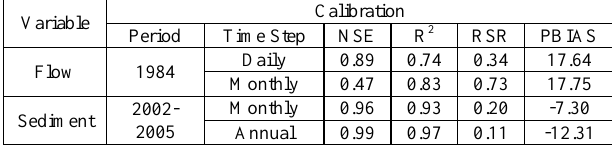
Table 4. Model Performance during calibration.